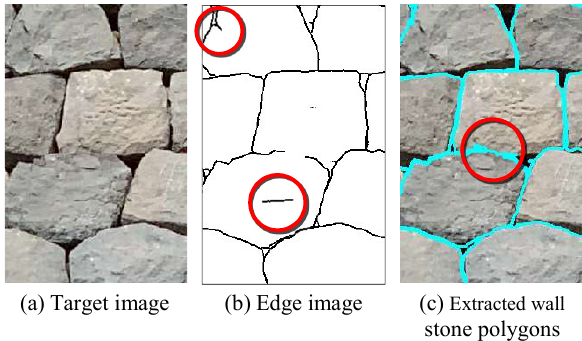
Figure 9. Effects of combinational use of edge image by Stacked cGAN and multiscale image